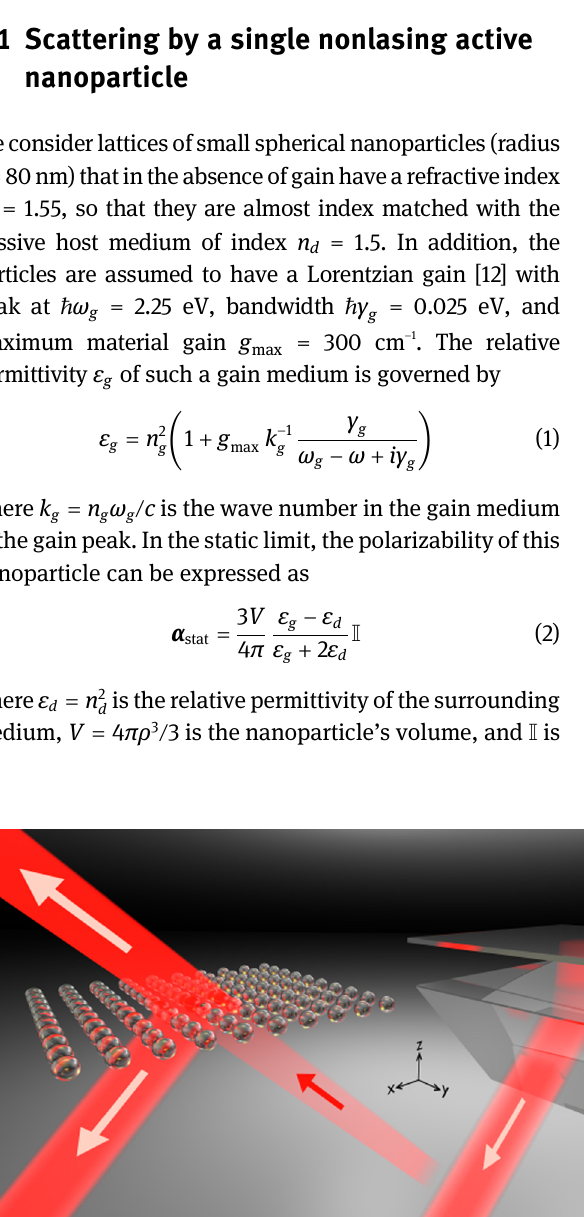
Figure 1: Photonic structures discussed in this work, featuring gain-induced phase singularities in the frequency – momentum space, accompanied by diverging ampli- tude of the scattering observables. Left: periodic array of weakly polarizable gain medium nanoparticles has scattering anomalies in transmission and reflection. Right: prism-coupled gain medium layer shows scattering anomalies in attenuated total internal